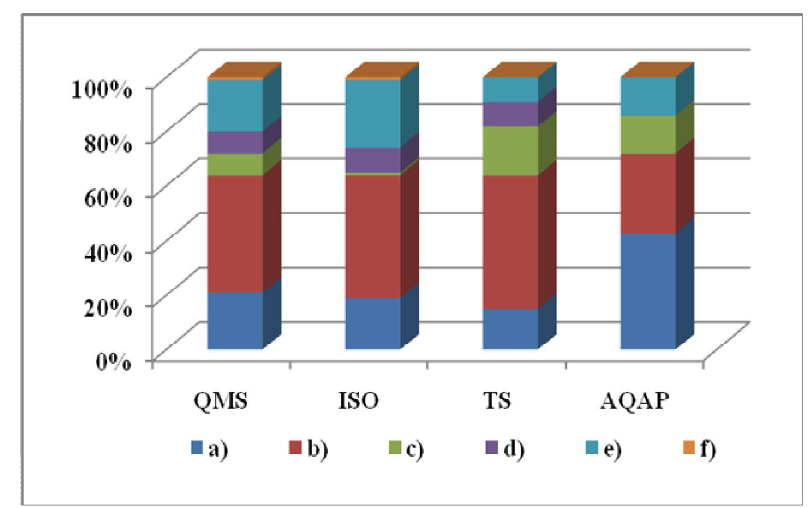
Figure 3 - Graphic representation of responses to question no.